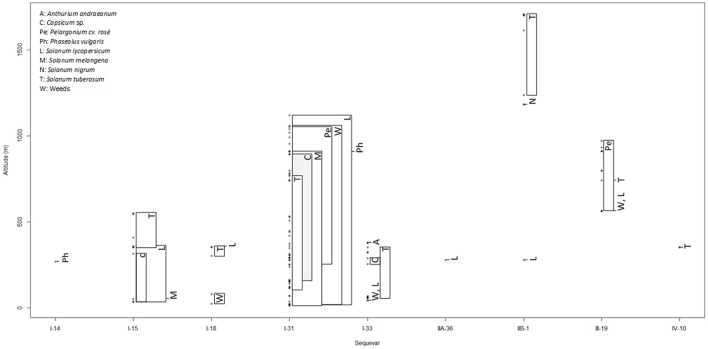
Distribution of sequevars of the RSSC depending on altitude and host of isolation in SWIO islands. For each sequevar, the dots correspond to the different altitudes of isolation. On the right of the dots, the letters indicate the host of isolation, and the rectangles mention the range of altitude of isolation for each plant.